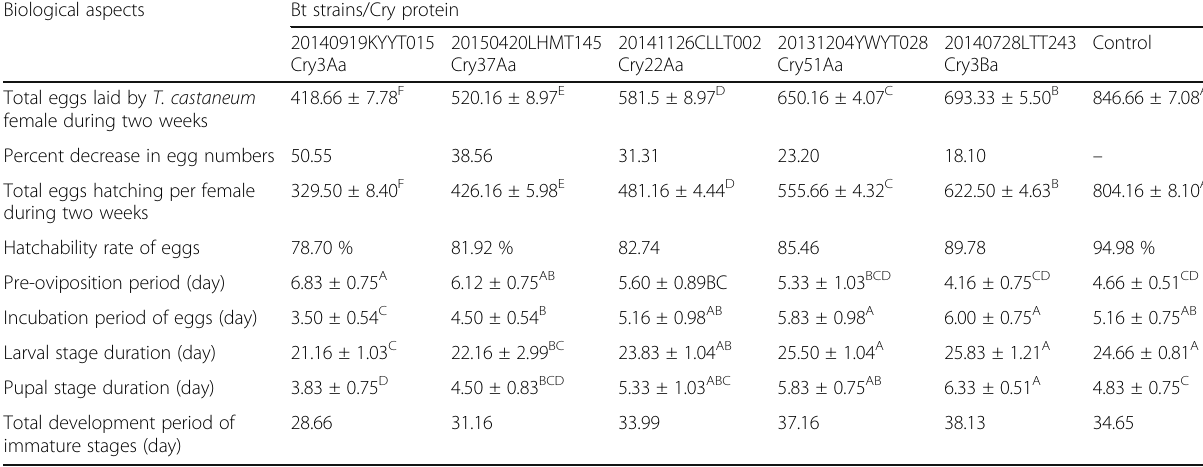
Table 4 Sublethal effects of LC30 values of five Bt strains/Cry proteins on certain biological aspects of Tribolium castaneum Biological